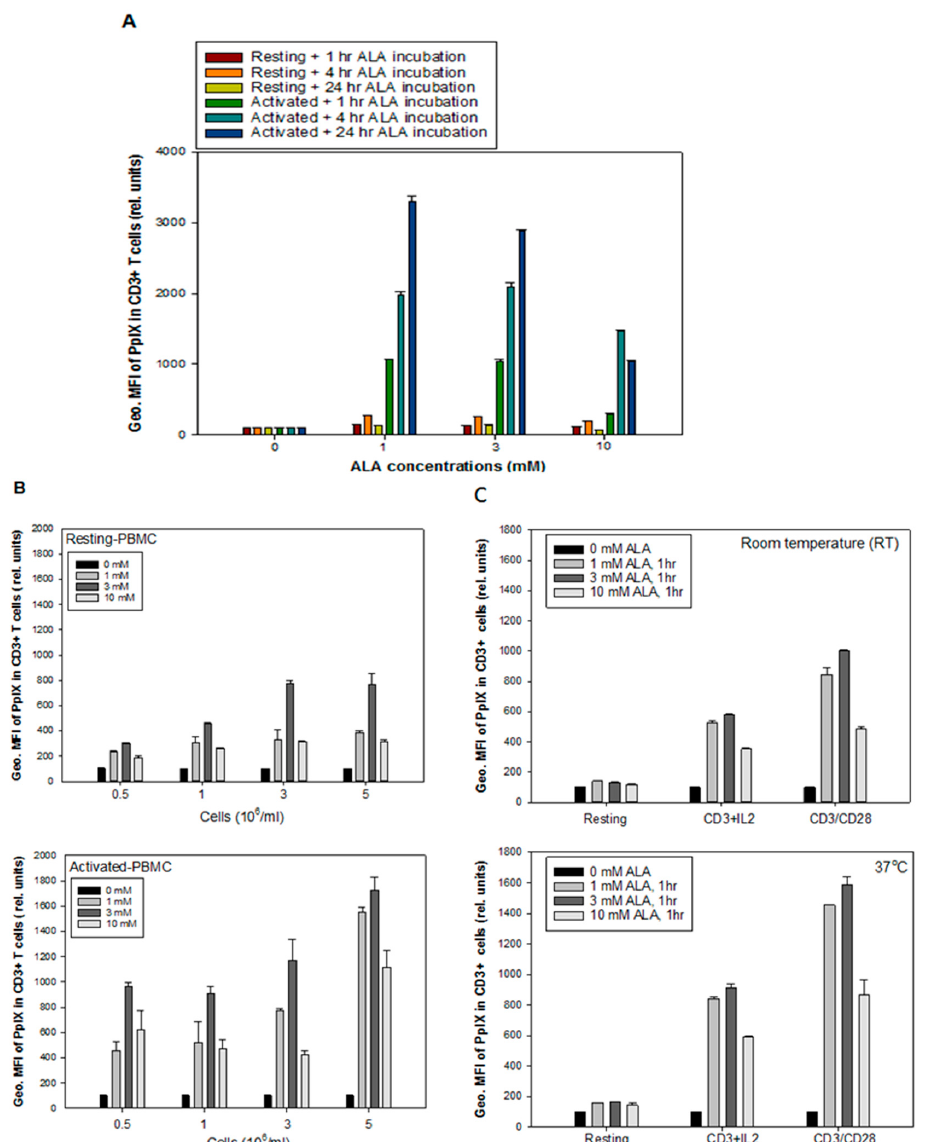
Figure 2. Effects of the parameters affecting ALA-induced PpIX production. Healthy donor PBMCs Figure 2. E ff ects of the parameters a ff ecting ALA-induced PpIX production. Healthy donor PBMCs were activated in vitro with anti-CD3/CD28 antibodies for 3 days. ( A ) effects of different ALA were activated in vitro with anti-CD3 / CD28 antibodies for 3 days. ( A ) e ff ects of di ff erent ALA incubation incubation time intervals on PpIX production in resting and anti-CD3/CD28 activated CD3 + T cells; time intervals on PpIX production in resting and anti-CD3 / CD28 activated CD3 + T cells; ( B ) the e ff ect ( B ) the effect of cell density on ALA-induced PpIX production; ( C ) the effect of temperature (RT and of cell density on ALA-induced PpIX production; ( C ) the e ff ect of temperature (RT and 37 ◦ C) on 37 °C) on ALA-PpIX production in resting, anti-CD3/IL-2 activated and anti-CD3/CD28 activated ALA-PpIX production in resting, anti-CD3 / IL-2 activated and anti-CD3 / CD28 activated PBMCs. PBMCs. The cell density also a ff ected the ALA-induced PpIX production. After 1 h incubation with various + ALA concentrations around 3- to 5-fold increase in the PpIX level in the CD3 T cells of activated + PBMCs ( p < 0.05) as compared to the CD3 T cells from resting PBMCs. An intermediate ALA dose of + 3 mM at a cell density of 3 to 5 × 10 6 cells / mL produced the highest amount of PpIX in the CD3 T cells from activated PBMCs (Figure